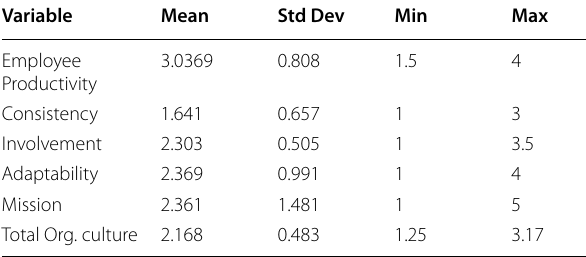
Table 5 Descriptive statistics